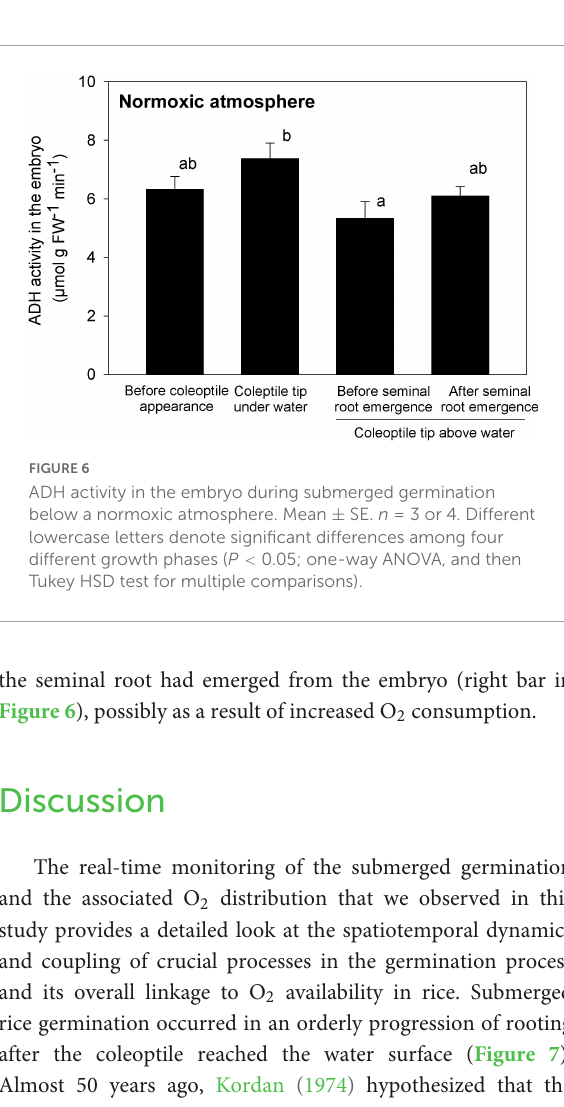
the seminal root had emerged from the embryo (right bar in Figure 6 ), possibly as a result of increased O 2